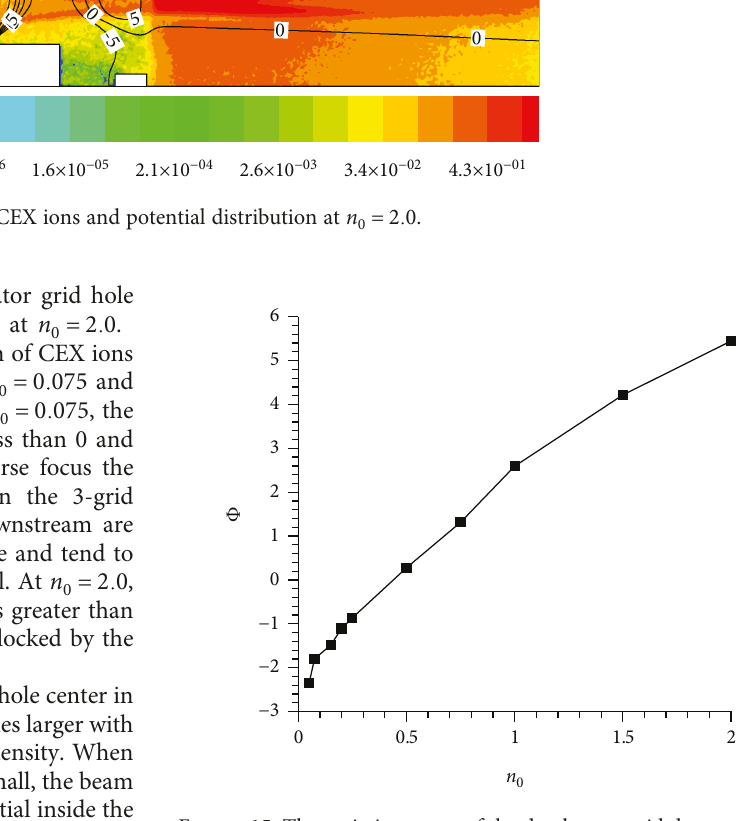
Figure 15: The variation curve of the decelerator grid downstream hole center potential with the upstream plasma number density in the 3-grid optical